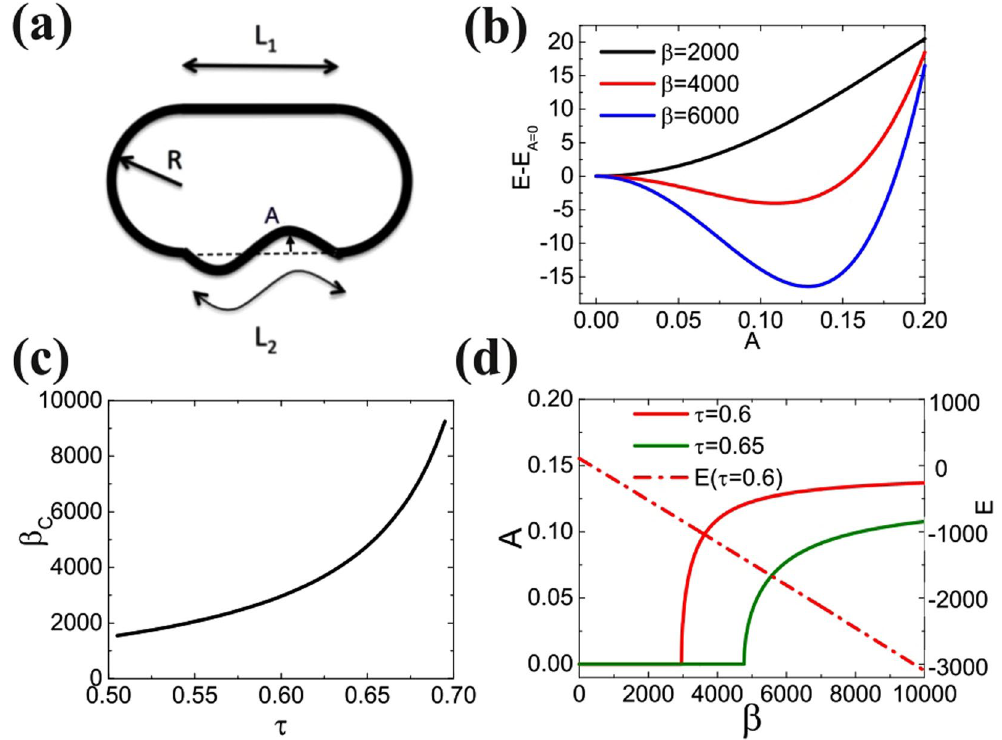
Figure 6. Analytical model: ( a ) Notations; ( b ) Total energy vs. amplitude for increasing adhesion energy; ( c ) buckling threshold vs. reduced area; ( d ) bifurcation diagram for τ = 0.6 and 0.65 and variation of the